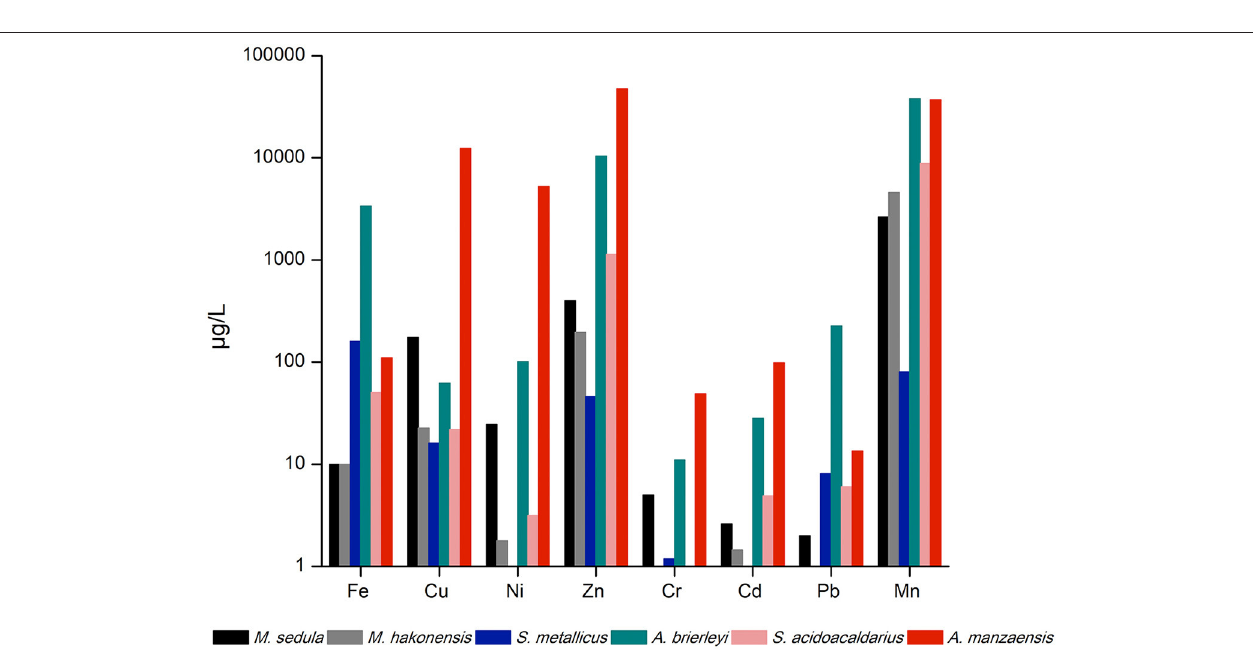
manzaensis tolerates pH ranges from 1.0 to 5.0 with the optimum being around 1.2–2.0 (Yoshida et al., 2006). ICP-MS